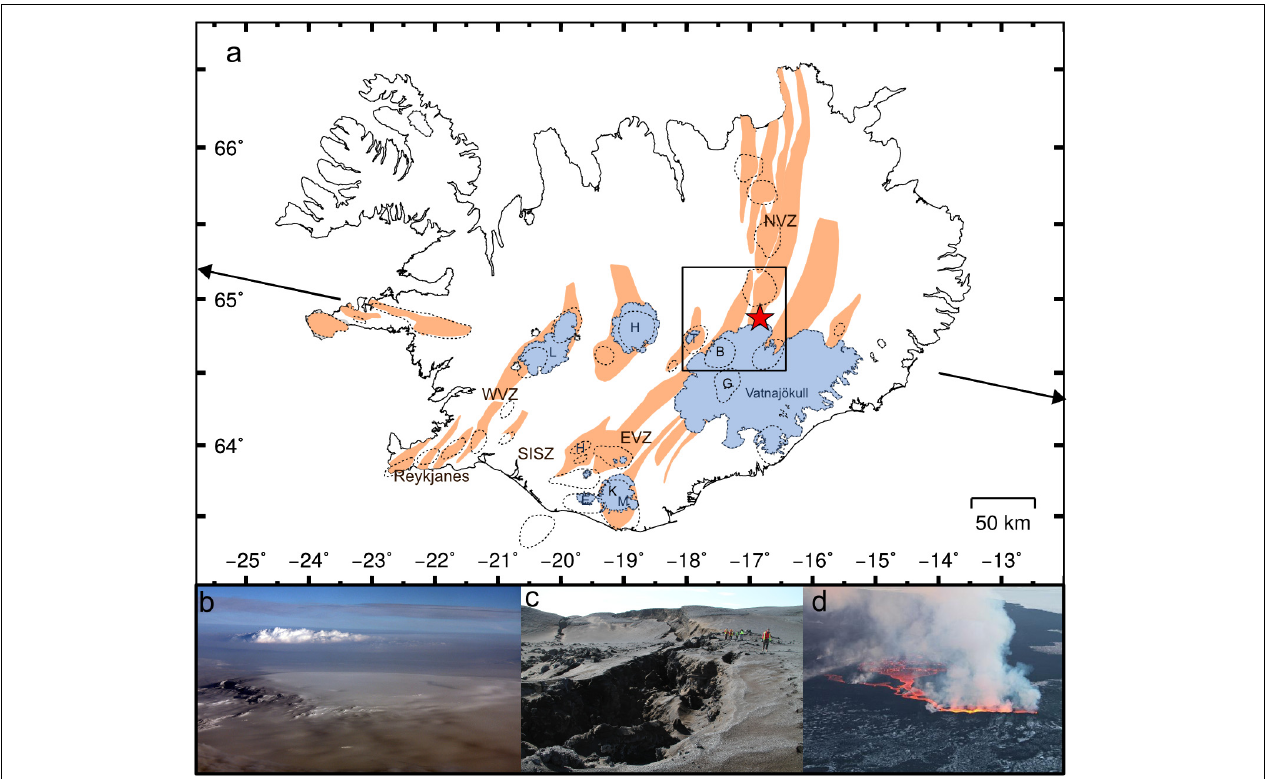
FIGURE 1 | (a) Volcano-tectonic map of Iceland showing fissure swarms (orange) and central volcanoes (dotted outlines) in neovolcanic zones (Johannesson and Sæmundsson, 2009), including: Reykjanes, the Western Volcanic Zone (WVZ), the South Iceland Seismic Zone (SISZ), the Eastern Volcanic Zone (EVZ), and the Northern Volcanic Zone (NVZ). The most active volcanoes include Hekla (H), Katla (K), Eyjafjallajökull (E), Grímsvötn (G) and Bár ð arbunga (B). Glaciers are also shown in blue with Hofsjökull (H), Langjökull (L), Mýrdalsjökull (M) and Tungnafellsjökull (T). The black box indicates the study area, where unrest at Bár ð arbunga caldera and Holuhraun eruption (red star) took place. The three pictures illustrate (b) the subglacial Bár ð arbunga caldera with the volcanic plume from Holuhraun eruption in the background (photo: Magnús T. Gudmundsson), (c) some fissures composing the dyke-induced graben nearby the eruption site (photo: Gro B. M. Pedersen) and (d) the large effusive Holuhraun eruption with the intense gas plume emitted from the main crater (photo: Gro B. M.